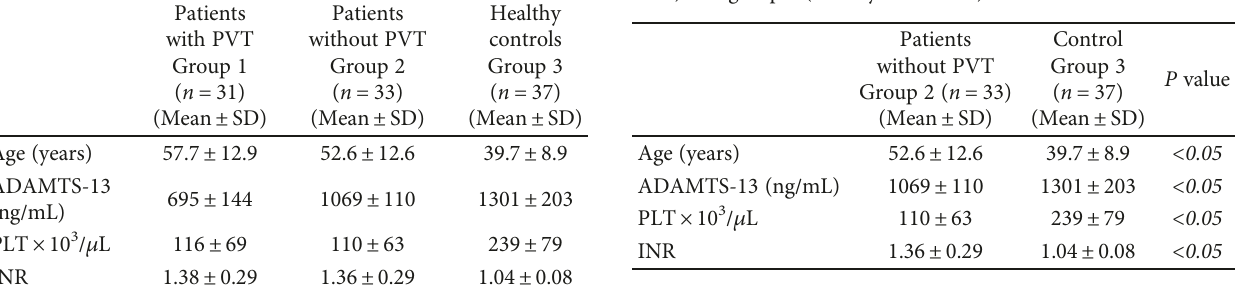
Table 4: Comparison of the analyzed markers in group 2 (without PVT) and group 3 (healthy volunteers).